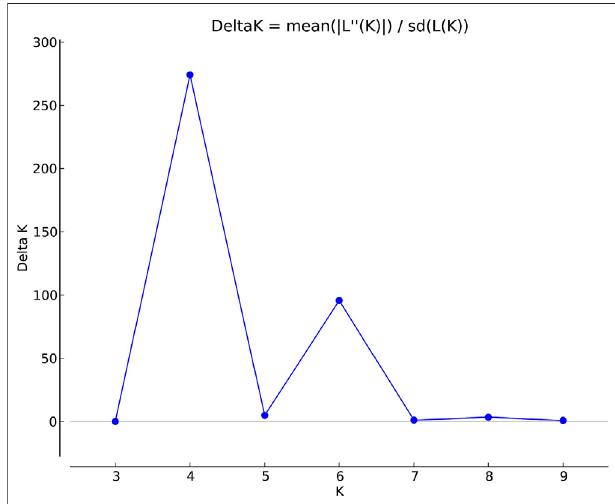
FIGURE7| EstimationofpopulationusingLnP(D)derived Δ kforkfrom2 to 10 of the east coast core collection.